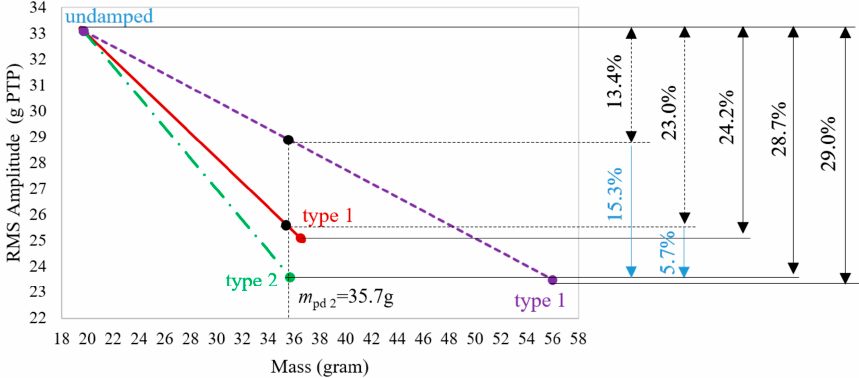
Figure 7. Comparison of root mean square (RMS)